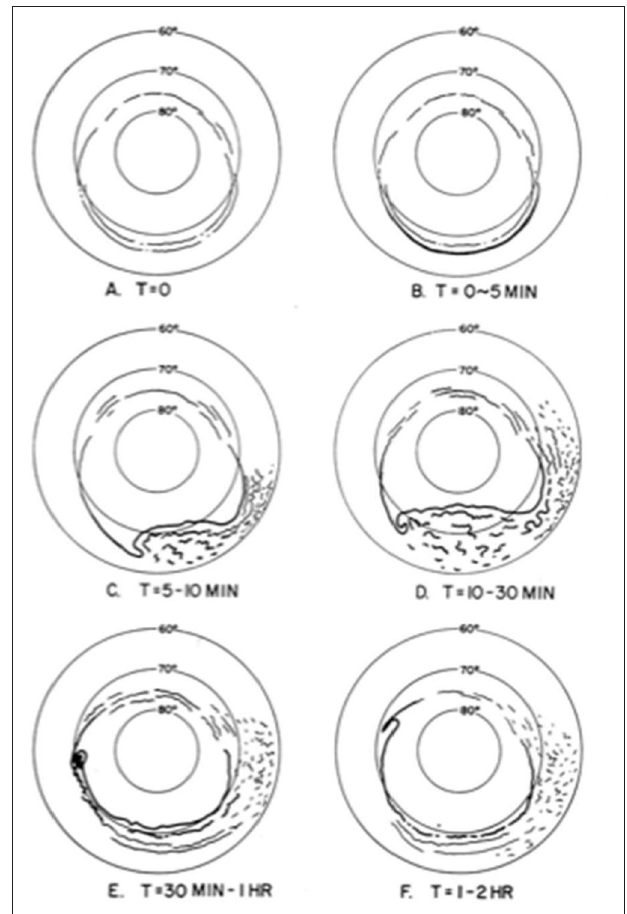
FIGURE 4 | A schematic illustration of the expansion phase of an auroral substorm ( Akasofu, 1964); the top of the circle is 12h (geomagnetic time) and the bottom is 0h, auroral arcs are shown by